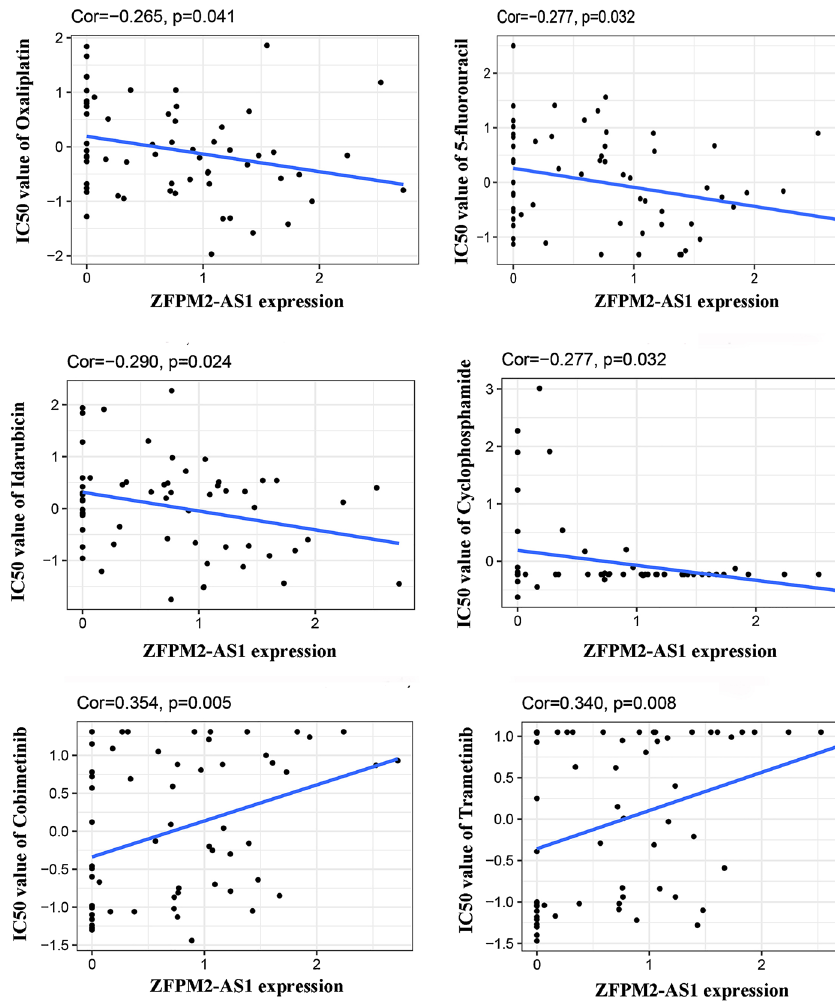
Fig. 8 The relationship between ZFPM2-AS1 and anticancer drugs sensitivity in